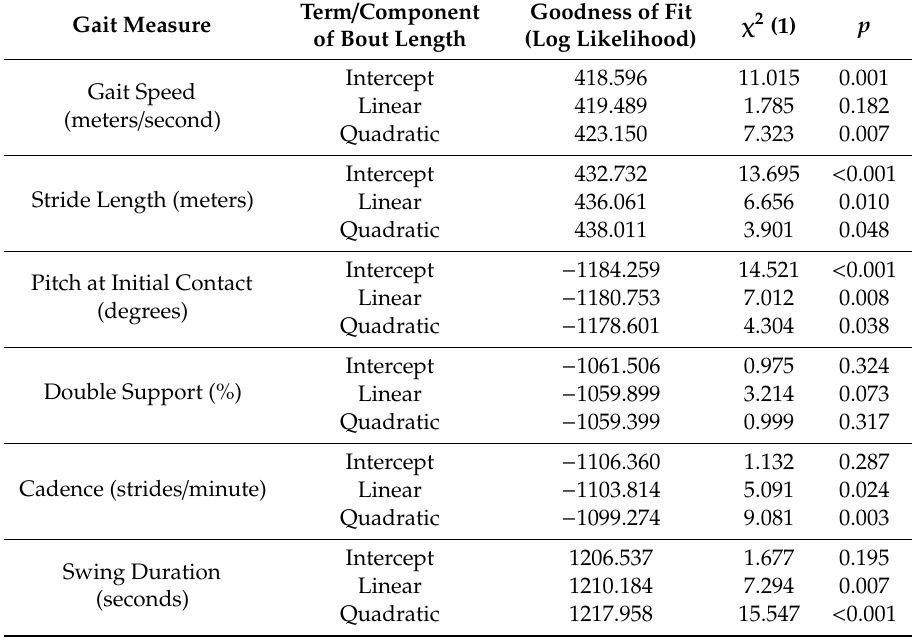
Table 2. Results of growth curve analysis with second-order (quadratic) orthogonal polynomial of bout length with the fixed e ff ect of group (OA and PD) for each gait